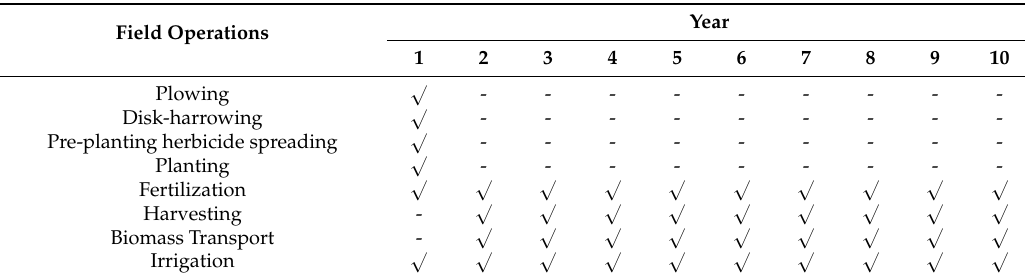
Table 1. Field operations for the ten-year